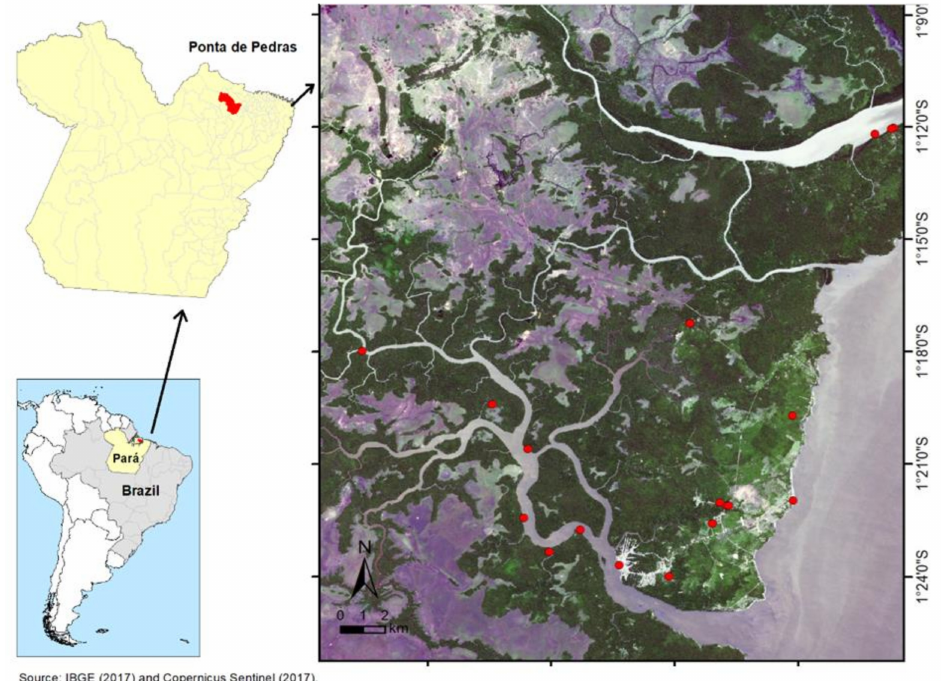
Figure 1. Map of the municipality of Ponta de Pedras, Par á State, Brazil (points in red: collection